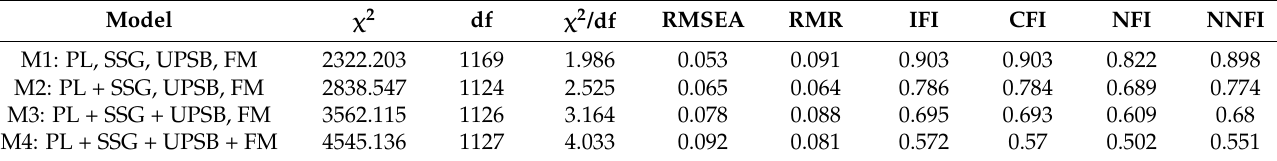
Table 2. Confirmatory factor analysis result.